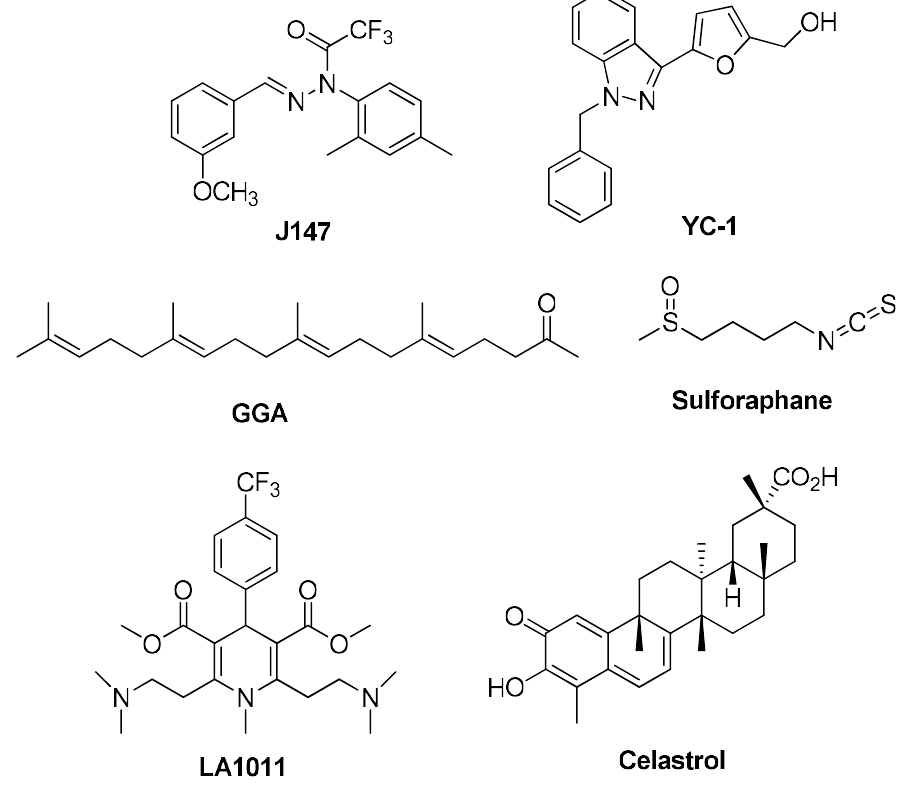
Figure 6. Chemical structures of modulators of Hsp70 expression.